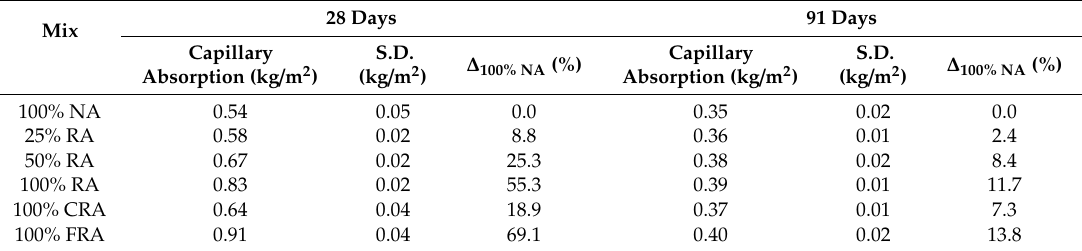
Table 5. Capillary water absorption results at 28 and 91